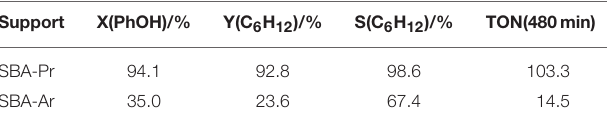
TABLE 3 | Pt supported on different carriers for HDO of phenol.